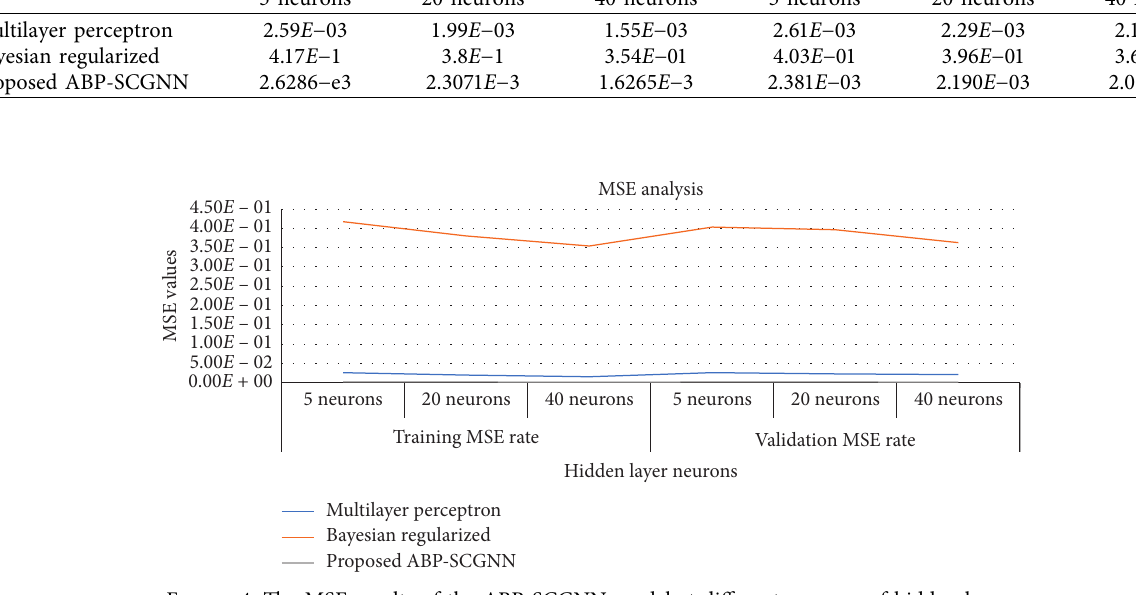
Table 3: The performance analysis of the ABP-SCGNN model compared with standard ANNs models using an MSE measure. Algorithms